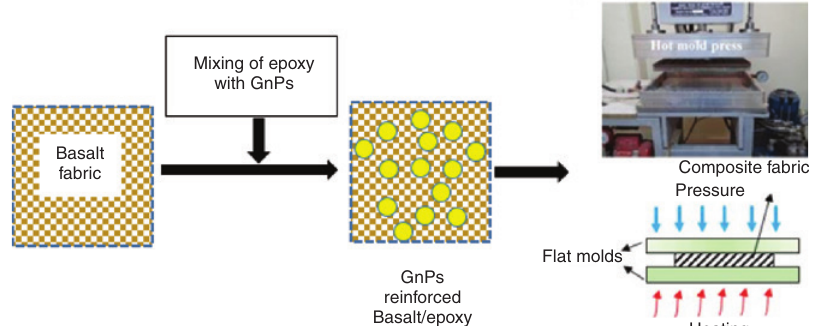
Figure 1: The production process for the composite